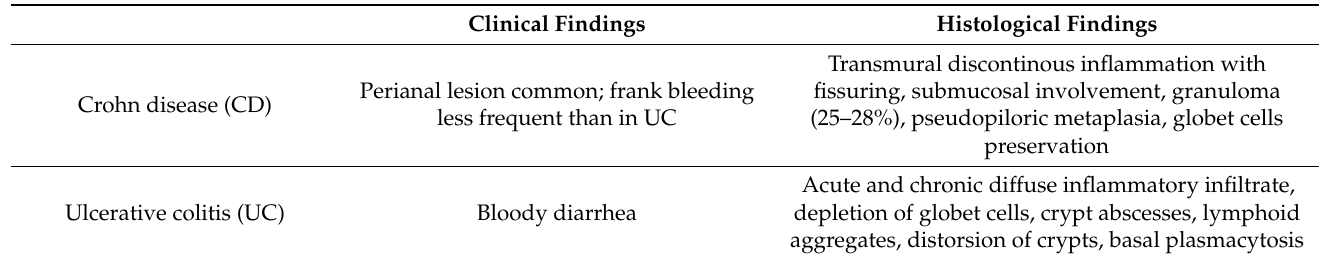
Table 3. Main features of CD versus UC. It should be noted that, in about 25–30% of cases, it is not easy to discriminate between the two diseases. Clinical Findings Histological Findings